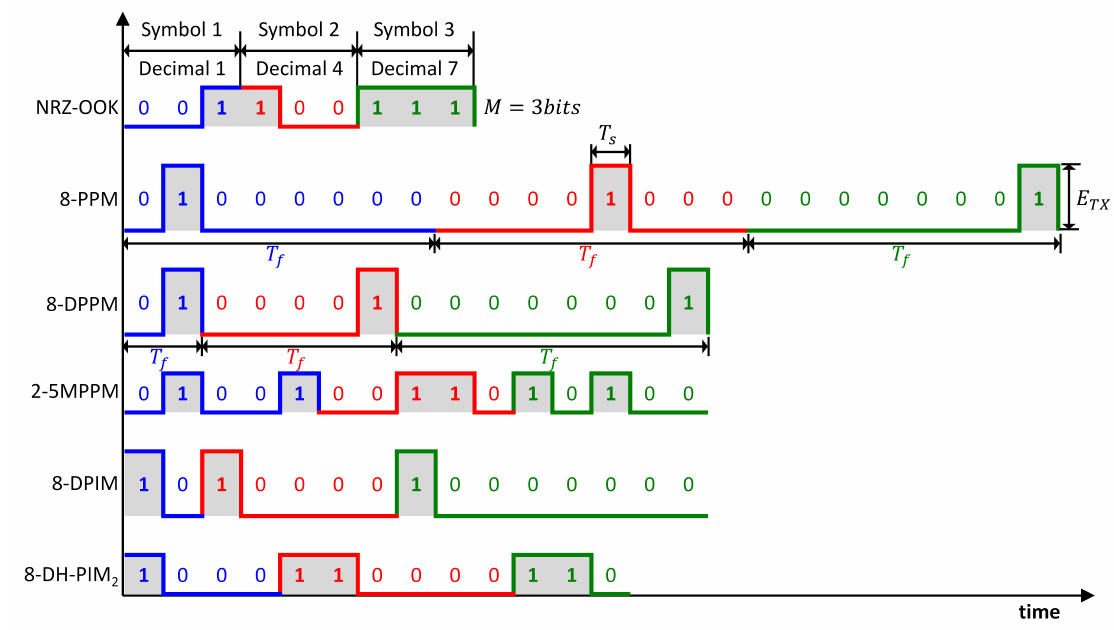
Figure 2. Time waveforms for on–off keying (OOK), pulse position modulation (PPM), differential PPM (DPPM), multipulse PPM (MPPM), digital pulse interval modulation (DPIM), and dual-header pulse interval modulation (DH-PIM) signals. The different symbols for the different modulation schemes shown in the figure are denoted by different